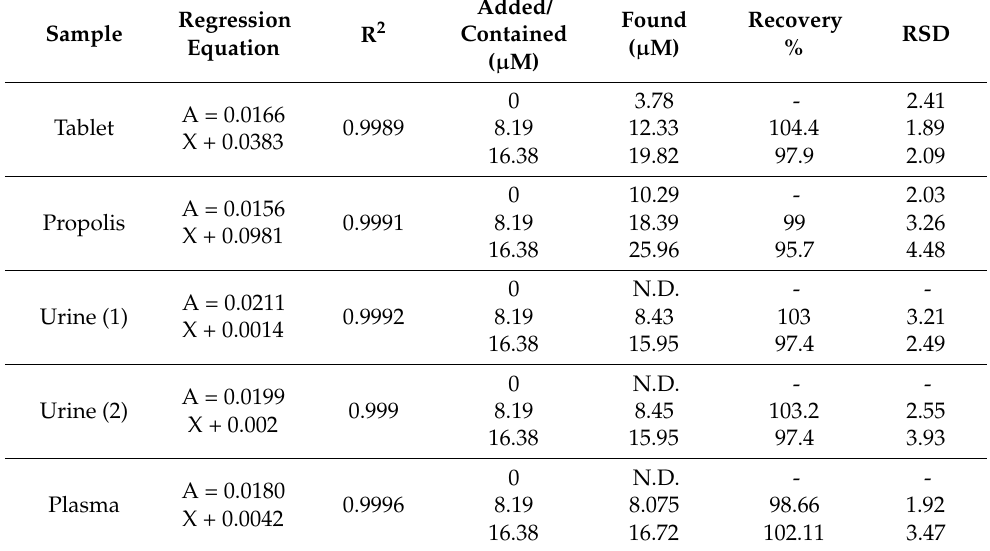
Table 2. Determination of Rtn in various real samples by the developed sensor.